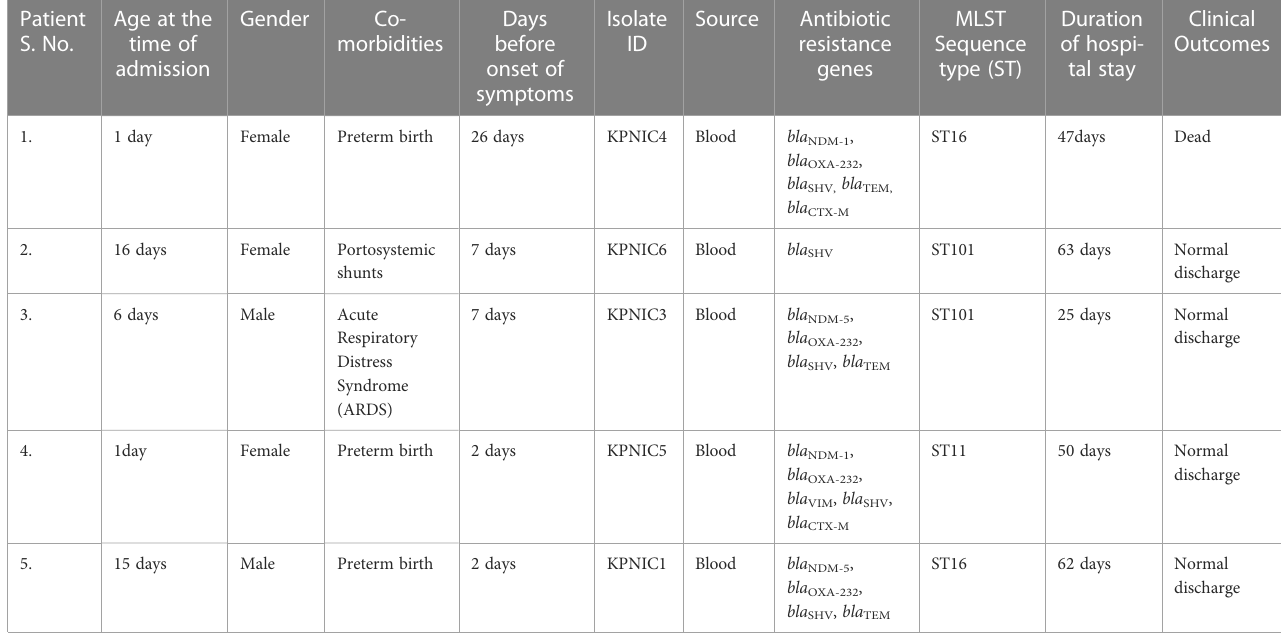
TABLE 1 Patient demographics and; details of K. pneumoniae isolates, sequence types and antibiotic resistance genes. Patient S.